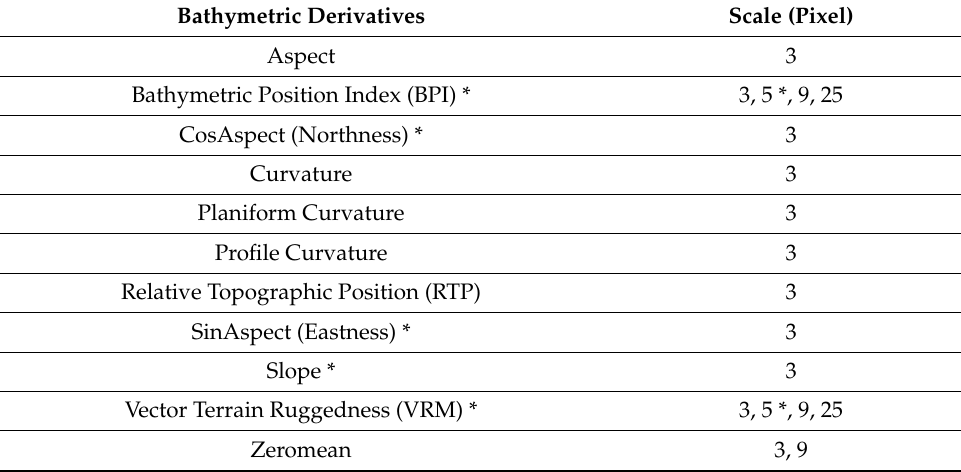
Table 2. Bathymetric derivatives extracted at each site. * Variable directly used in the segmentation